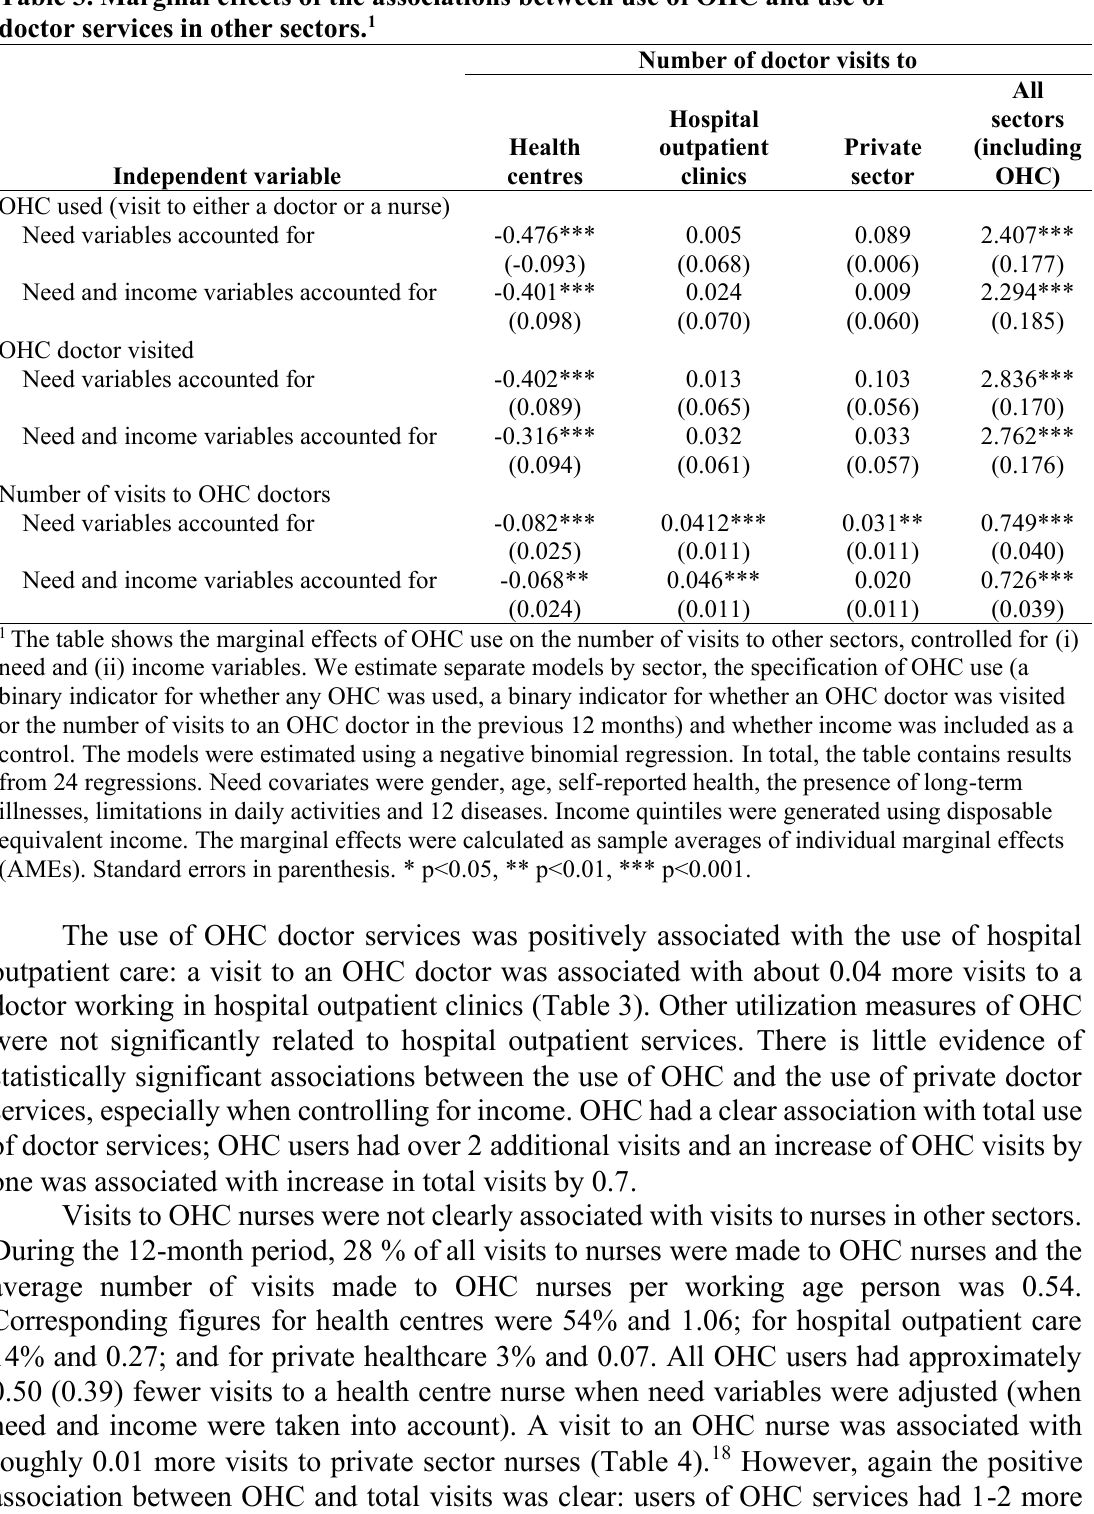
Table 3. Marginal effects of the associations between use of OHC and use of doctor services in other sectors. 1